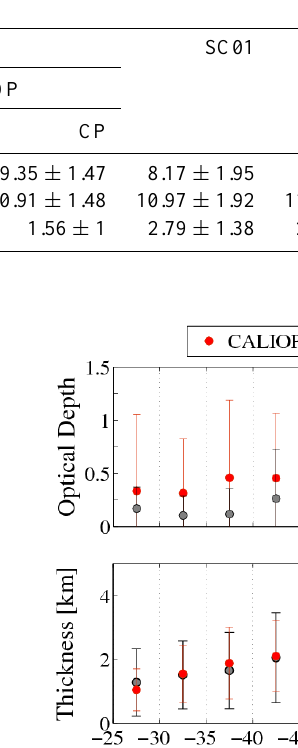
Table 2. Cirrus clouds macrophysical properties comparison. CBH, CTH and CT represent respectively the Cloud Top Height, Cloud Base Height and Cloud Thickness. Extended Period (1996–2007 and 2006–2012, respectively for the ground-based lidar and CALIOP) is repre- sented by EP and Coincident Period between the ground-based lidar and CALIOP over the OHP (June 2006 to June 2007) by CP. Previous mid-latitude studies are represented by SC01 (Sassen and Comstock, 2001), G07 (Giannakaki et al., 2007) and M11 (Min et al., 2011).